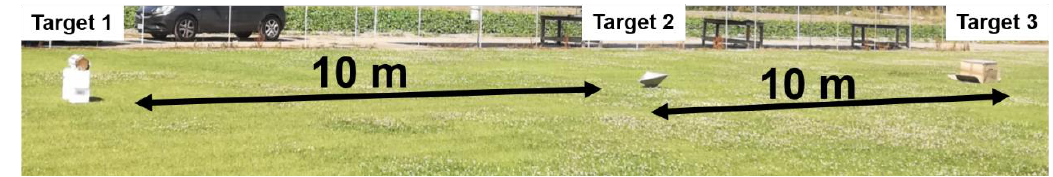
Figure 6. First test case: radar imaging scenario.